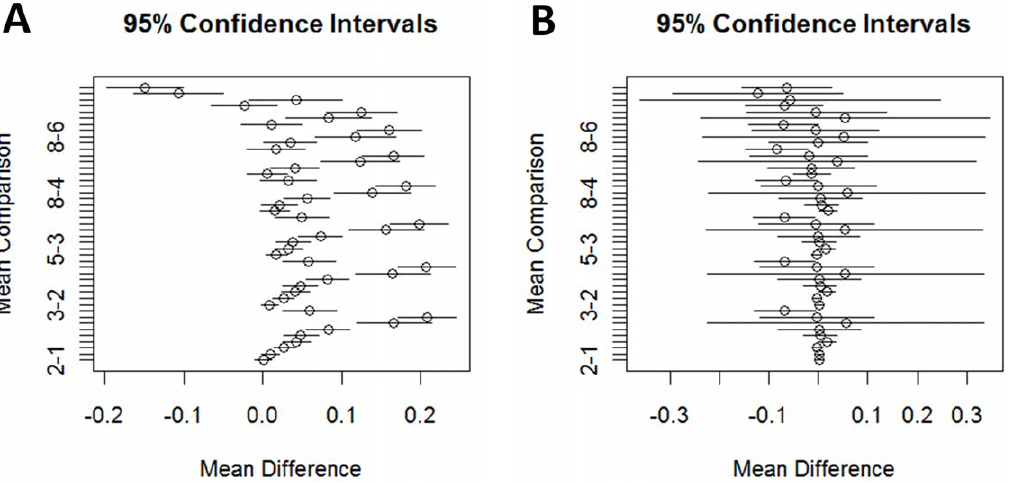
Figure 2. Representative SCUO variance plots. Mean differences of SCUO variance between gene groups with 10 different intervals (see Table S4) of codon usage orders. The pair-wise intervals are shown on y-axis and the mean differences are represented by the x-axis. The 95% confidence intervals for each of the pair-wise comparisons are shown by horizontal bars with the middle circle representing the mean difference value. The two plots represent two ant genomes; A) jumping ant ( Harpegnathos saltator ) and B) Argentine ant ( Linepithema humile ).